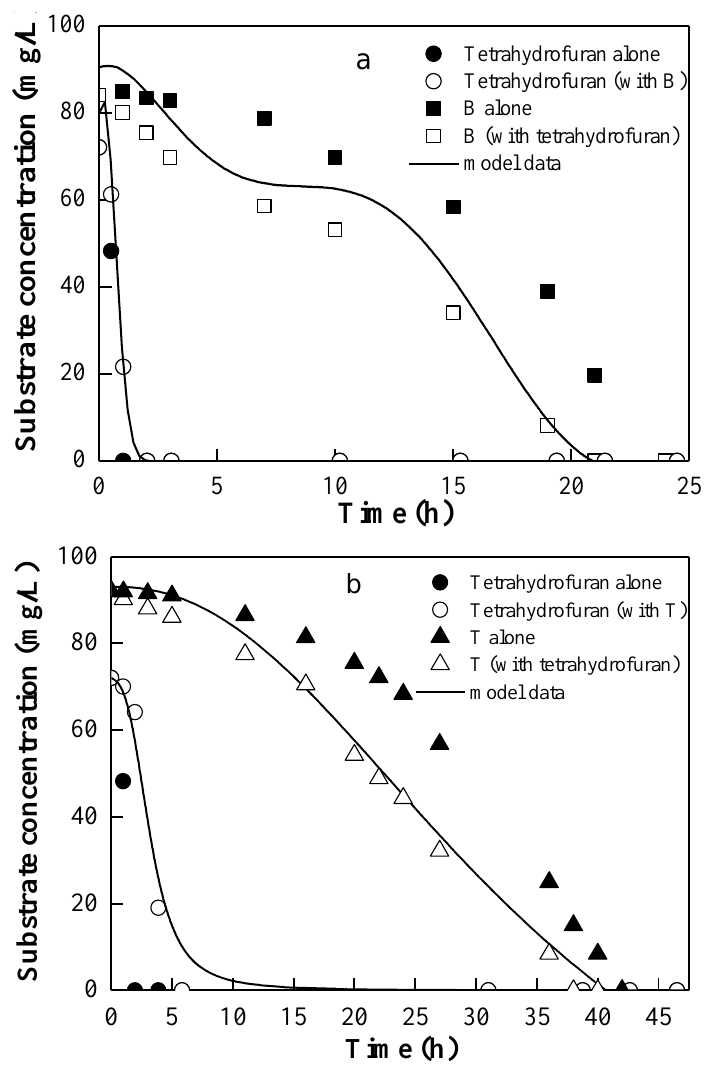
Figure 2. Dual degradation of tetrahydrofuran with mixture of ( a ) B or ( b ) T presented by experimental data (shapes) and sum kinetics with interaction parameter (SKIP) model (lines). The initial culture density in each bottle was 20